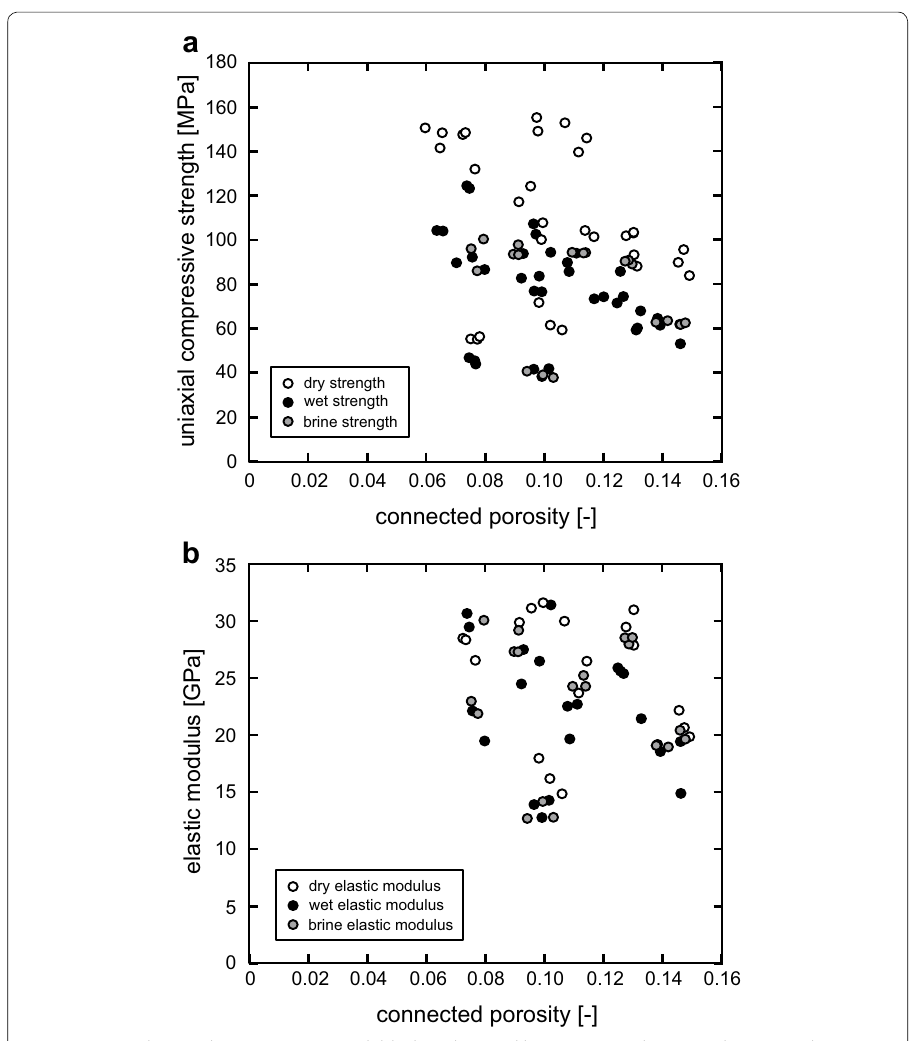
Fig. 6 a Dry (white circles), water-saturated (black circles), and brine-saturated (grey circles) uniaxial compressive strength for the six sandstones sampled from exploration well EPS-1 at Soultz-sous-Forêts (France) as a function of connected porosity. b Dry (white circles), water-saturated (black circles), and brine-saturated (grey circles) static elastic modulus for the six sandstones sampled from exploration well EPS-1 at Soultz-sous-Forêts as a function of connected